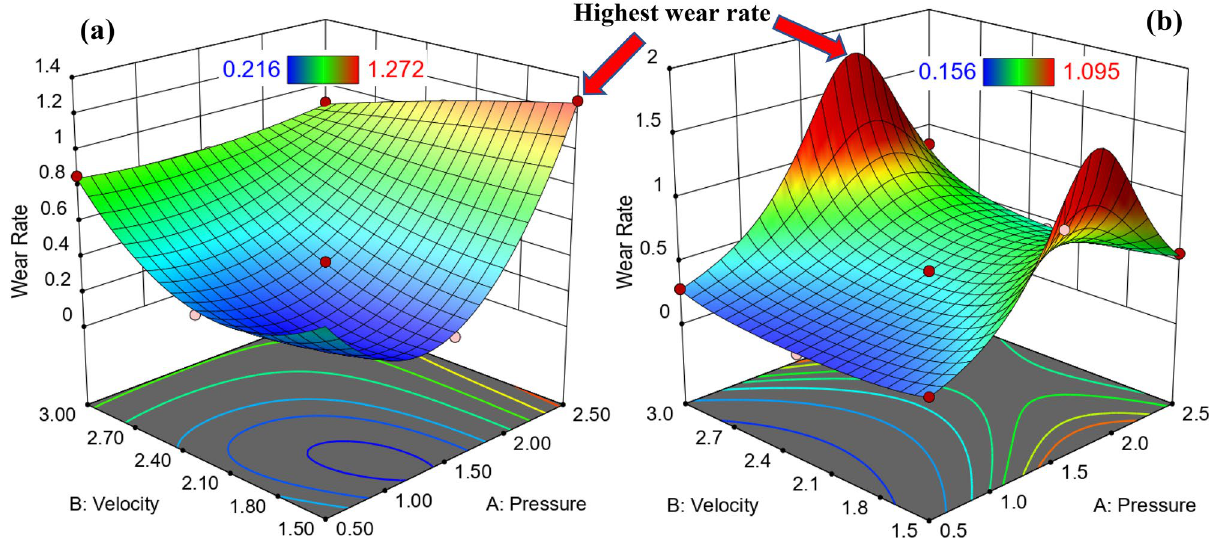
Figure 3. 3D surface plot for wear rate relating to pressure and velocity: ( a ) hot-rolled and ( b ) QAM f